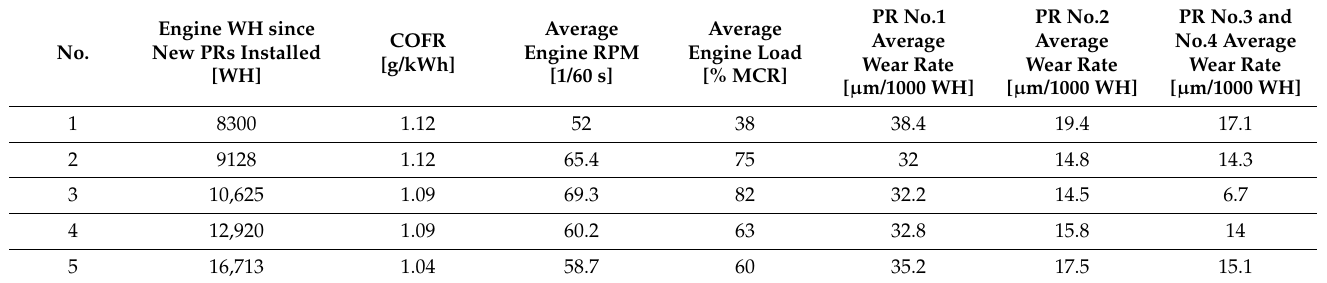
Table 3. Research test results obtained during assessment of Engine No. 3 PRs wear